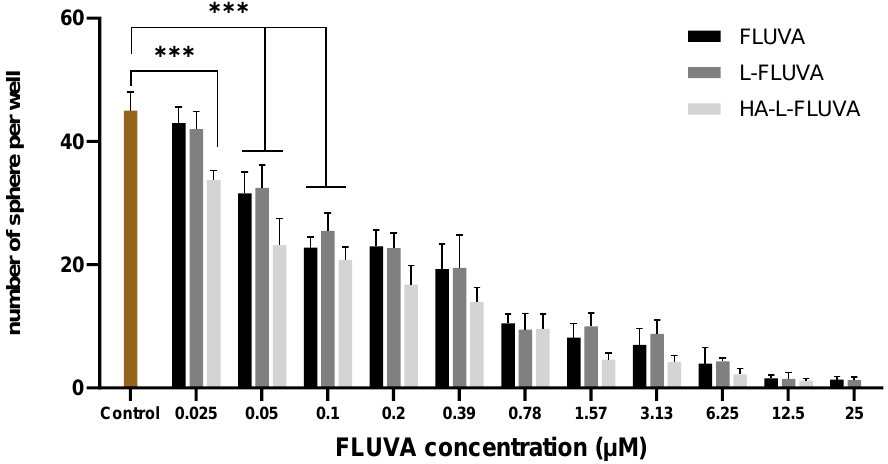
Figure 2. Number of spheres with a diameter of ≥ 100 µ m (mean ± SD, *** p <